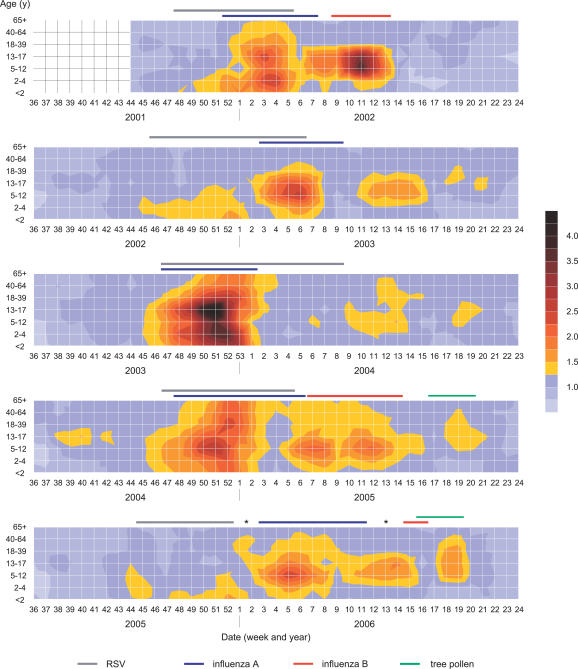
Observed Fever and Respiratory ED Visit Surface Plots by Age Group in New York City during the 2001–2002 to 2005–2006 Influenza SeasonsEach season is shown from early September through mid-June by CDC week and year. Weeks of predominant influenza A (blue bar) or B (red bar) isolate surveillance during the study period, retrospectively identified predominant RSV hospitalizations through 2005 (gray bar), and dominant tree pollen periods for 2005 and 2006 (green bar) are shown above each season. Weekly ED visits by age group were detrended and normalized: age-specific intensity is shown as a color gradient interpolated between data points, with observed visits ranging from 2 to >4 times mean noninfluenza levels during peak epidemic weeks, and 0.25 to 1.25 during nonepidemic periods. Visits were increased across all age groups during periods of influenza A/H3N2 predominance, and were most markedly increased during the 2003–2004 and 2004–2005 A/Fujian-lineage epidemics. Visit increases during periods of influenza A/H1 and B predominance impacted preschool (2–4 y) and school-aged (5–17 y) children, and were most dramatically elevated during the B/Victoria-lineage reemergence in early 2002. The autumn and early-winter predominance of RSV preceded influenza in 2001, 2002, and 2005, and coincided with increased visits in the < 2 y and 2–4 y age groups. Visits were notably increased among school-aged children and working-aged adults during the dominant tree pollen period in 2006. RSV hospitalization data were not available for 2006 (*), and viral influenza surveillance reporting was incomplete during weeks 12 to 16, 2006 (*).